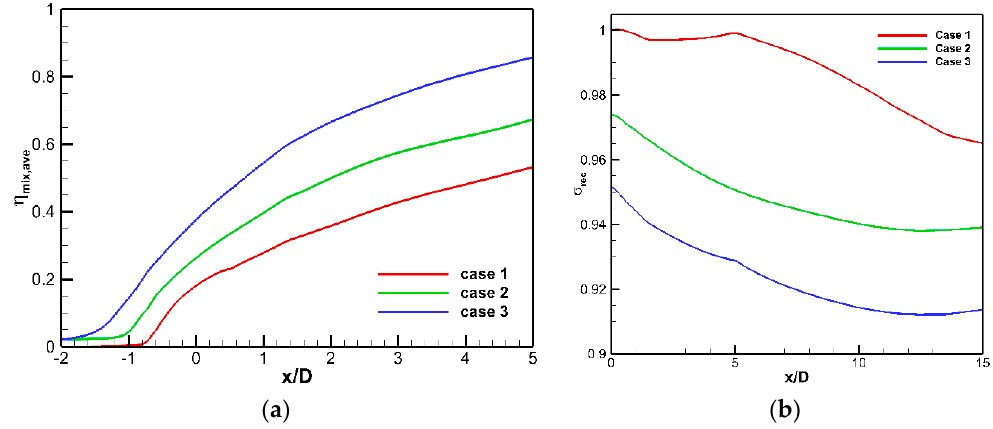
Figure 18. Time-averaged mixing efficiency ( a ) and total pressure recovery coefficient ( b ) along the flow direction for three cases.